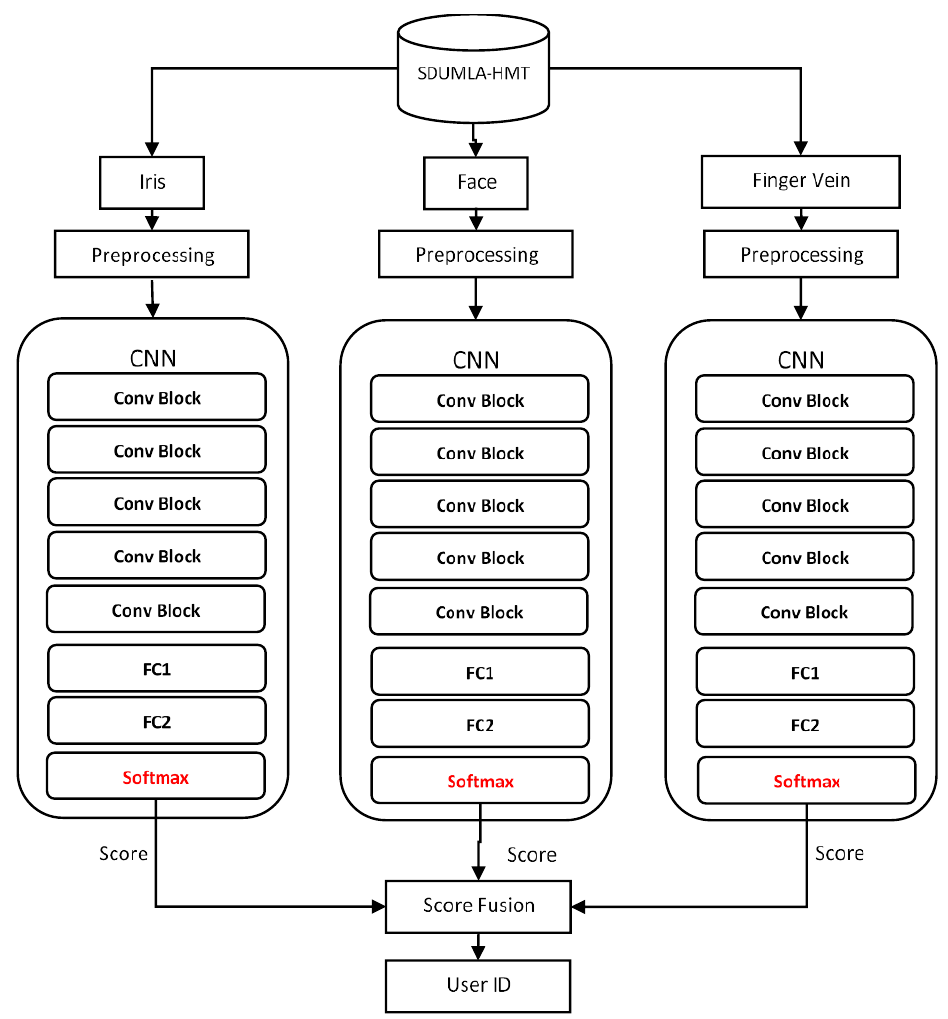
Figure 3. The framework of the multimodal biometric model using a score-level fusion approach. Conv Block represents a block of convolutional layers and pooling layers, and FC is a fully connected layer.